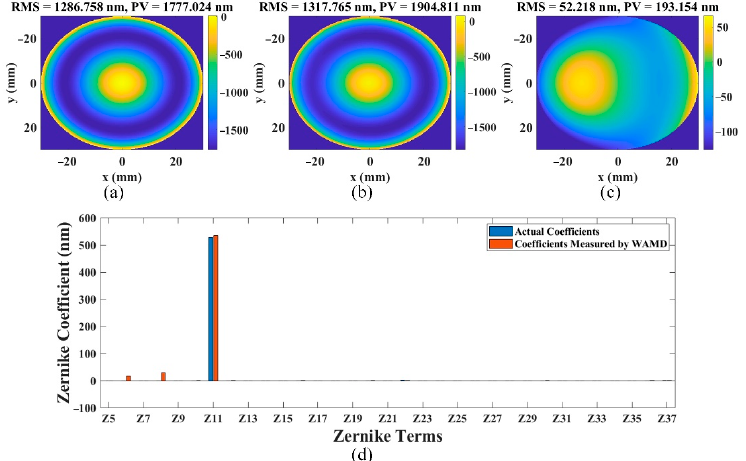
Figure 10. Wavefront aberration of the plano-convex lens in the simulation when alignment errors exist: ( a ) actual wavefront aberration; ( b ) wavefront aberration measured by WAMD when the LUT was 5 mm off-axis in the x-direction and rotated 1° about the x axis; ( c ) difference between ( a , b ); ( d ) comparison of Zernike coefficients